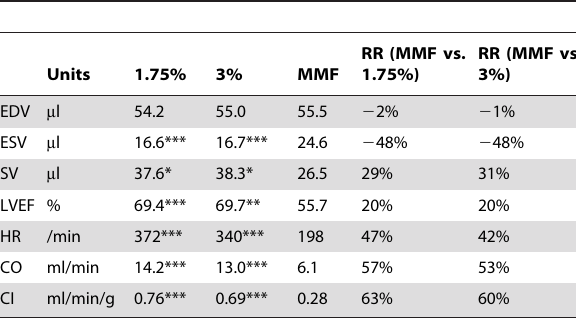
Table 3. Left ventricular function parameters in healthy mice under different anesthetic regimen.